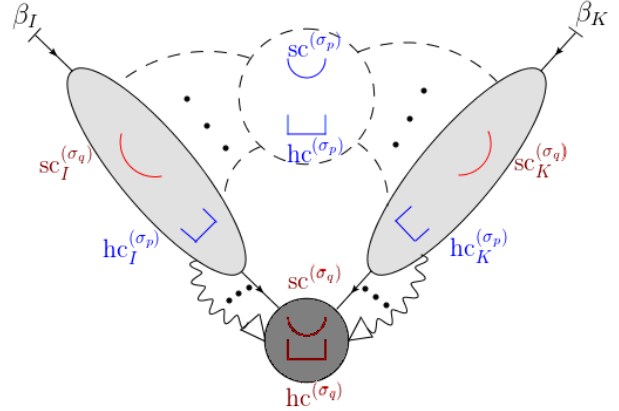
Figure 27. The pinch surfaces (cid:26) f (cid:27) n :::(cid:27) 1 g of a back-to-back decay process as an example. As is indicated in the text, the approximations from t (cid:27) and we mark them blue. In comparison, the approximations from t (cid:27) and hard subgraphs, which we mark dark